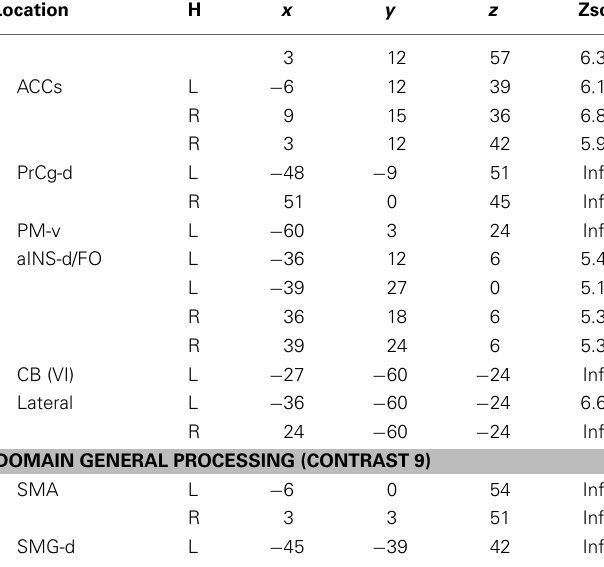
Table 6 | Brain areas associated with motor execution of speech, domain general processing, or